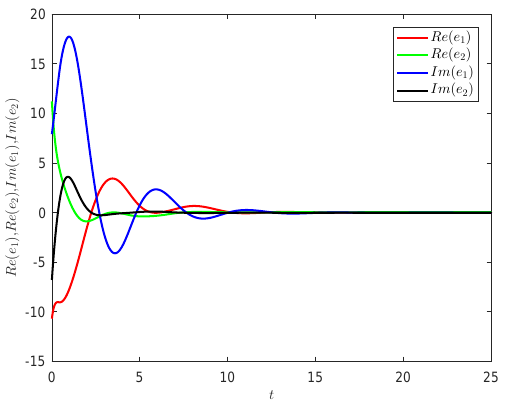
Figure 3. The curves dynamics of error system e ( t ) in Example